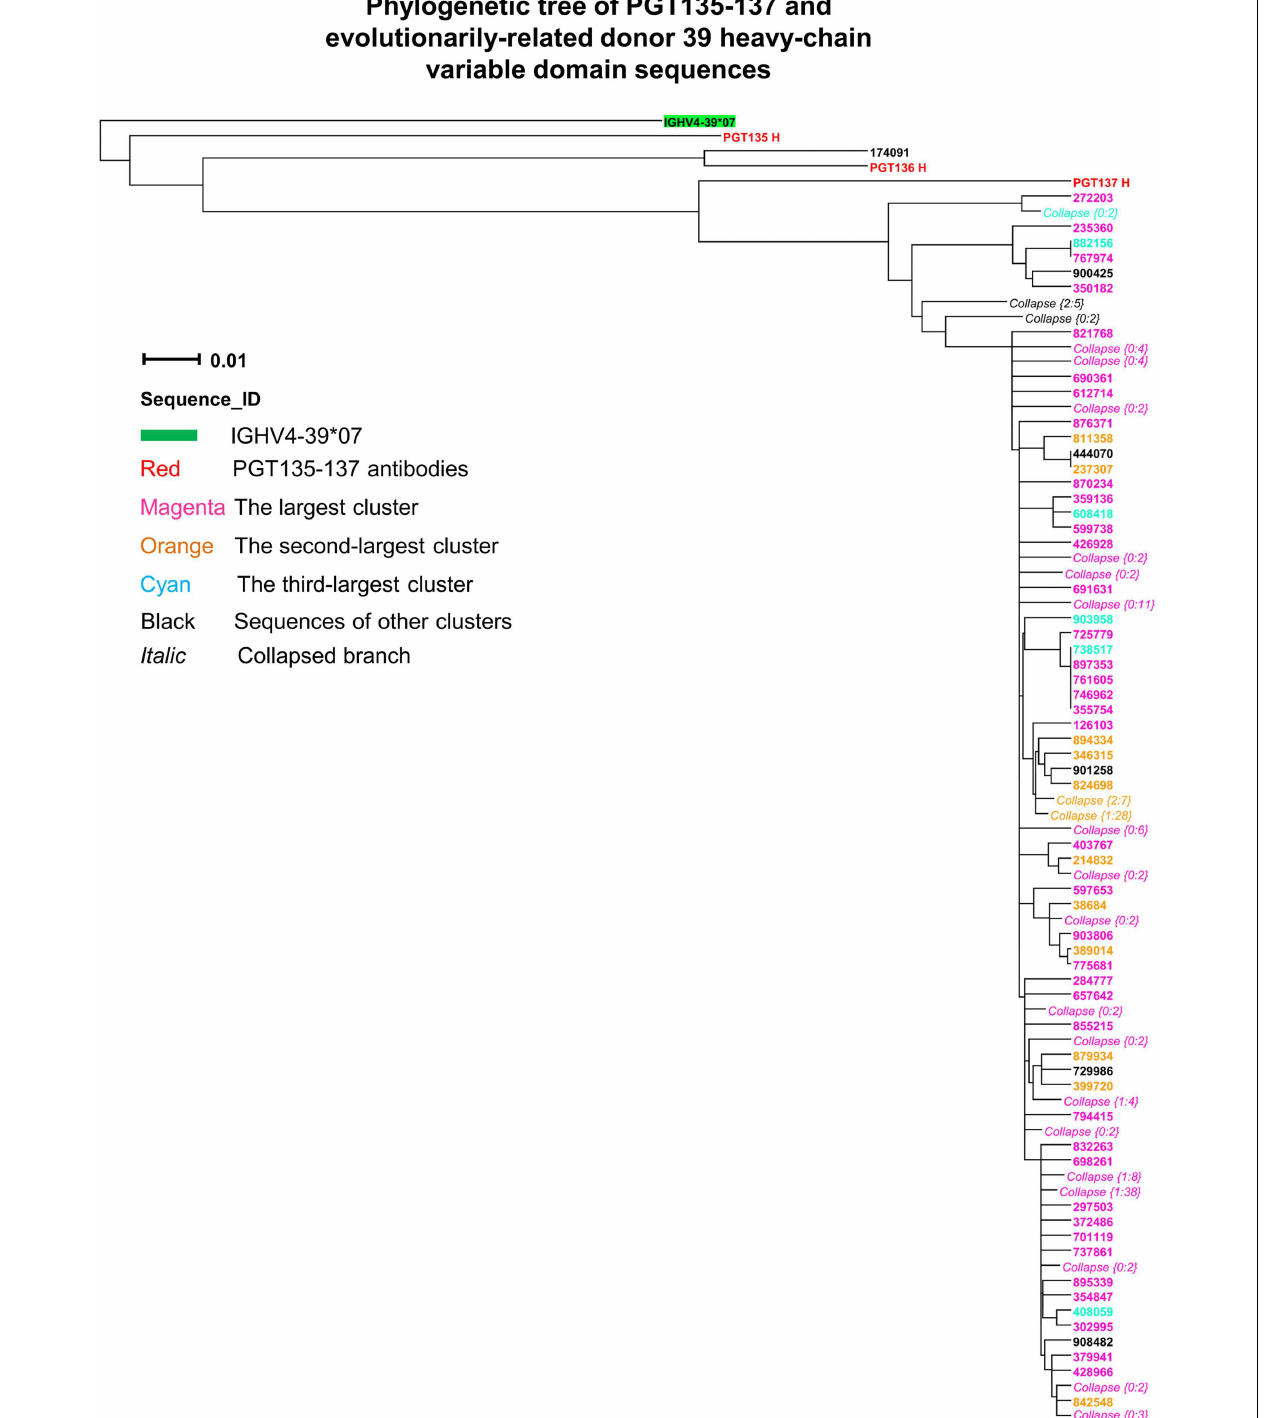
FIGURE 3 | Evolutionary similarity of PGT135–137 to donor 39 heavy-chain variable-domain sequences. Germline-rooted maximum-likelihood tree of PGT135–137 and 202 sequences identified by the iterative intra-donor phylogenetic analysis of donor 39 heavy-chain variable domain sequences determined by 454 pyrosequencing.The iterative